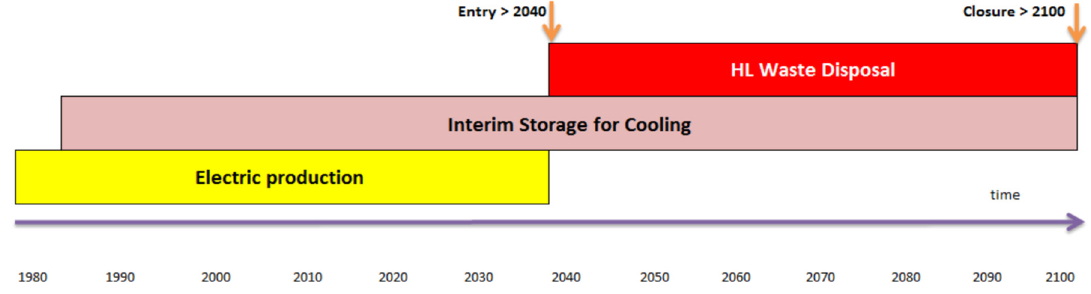
Fig. 2. Example of waste disposal schedule (stylized case study).